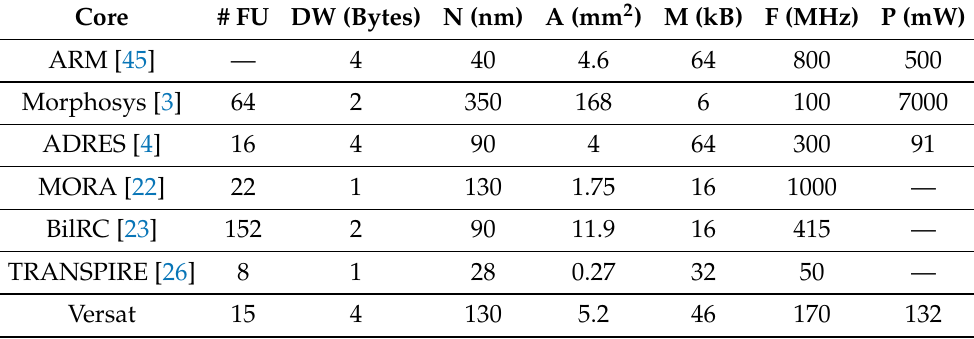
Table 4. Integrated circuit implementation results.